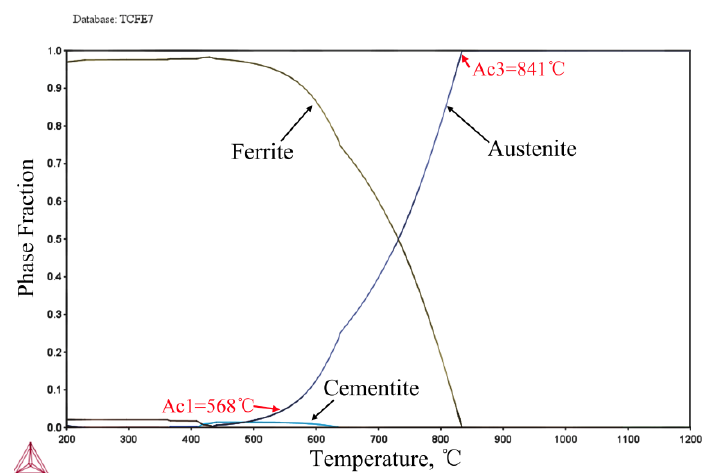
Figure 1. Equilibrium phase fractions of ferrite, austenite and cementite as a function of temperature.